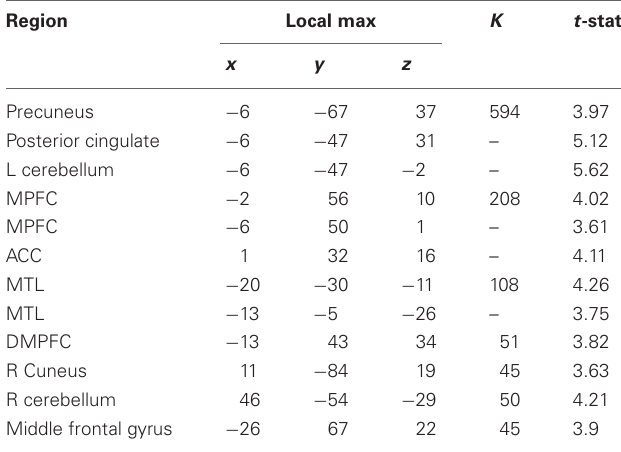
Table 3 | Associations between neural activity in participants’ brains and ratings of interest of their post-scan descriptions. Table 3A | Positive correlations with positive sentiment, as rated by the automated sentiment analyzer.